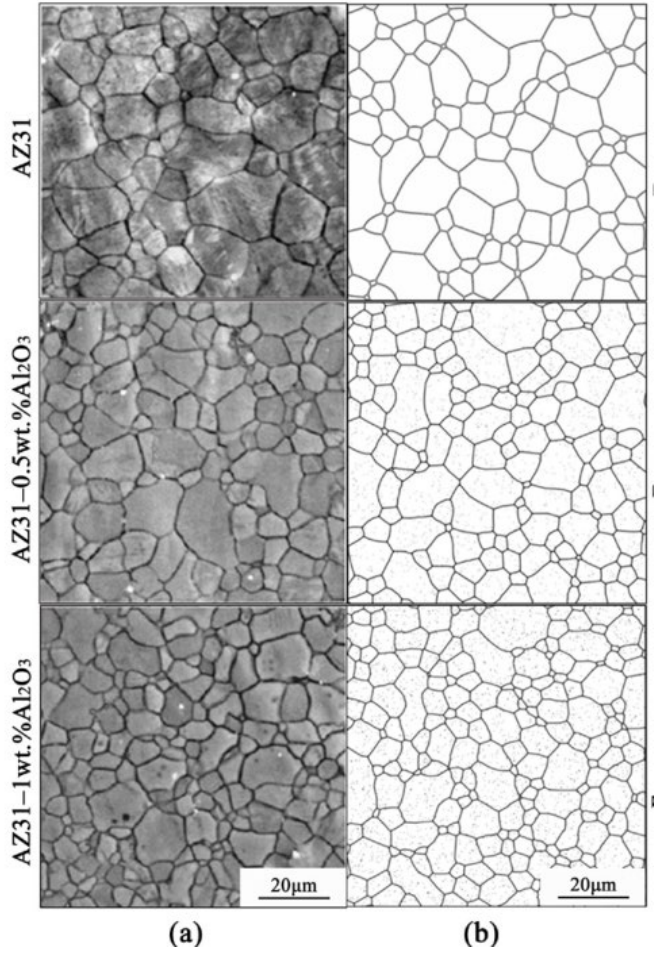
Figure 15. Effect of different Al2O3 particles content on grain size: ( a ) experimental observation;( b ) phase-field simulation [118].